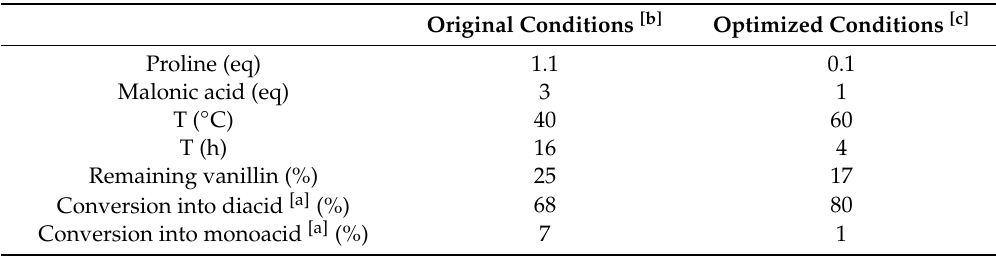
Table 3. Optimization of the proline-catalyzed Knoevenagel condensation of vanillin and malonic acid in ethanol (0.5 M).